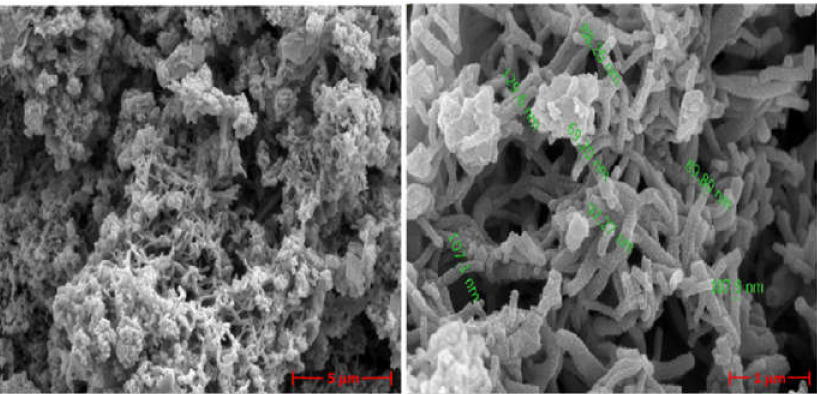
Figure 2. SEM images of the surface of sodium phytate doped PANI at a magnification of 20 k ( left ) and 80 k ( right ).